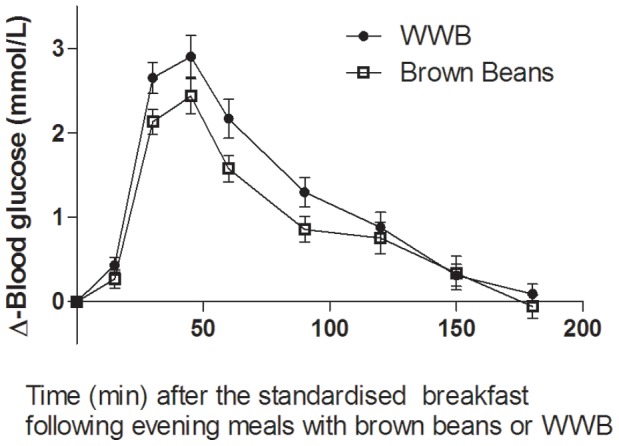
Mean incremental changes (Δ) in blood glucose concentrations after the standardized breakfast consumed 11 hours after evening meals composed of brown beans or WWB.A significant treatment (type of evening meal) effect was found over the test period (p<0.05, PROC MIXED in SAS release 9.2; SAS Institute Inc, Cary, NC). n = 16 subjects.